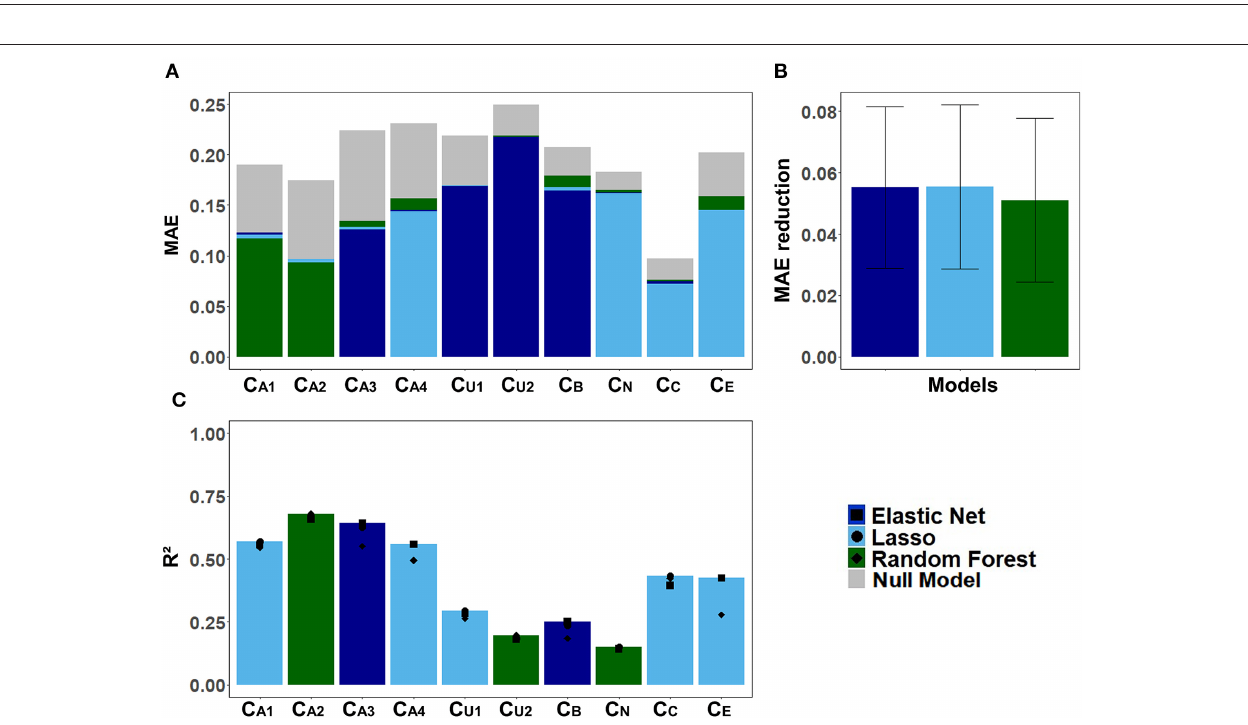
FIGURE 5 | Training and test set loss function (MAE) across CAFPAs for the three models (A) lasso regression, (B) elastic net, and (C) random forest. MAE values correspond to a randomly selected imputed data set.